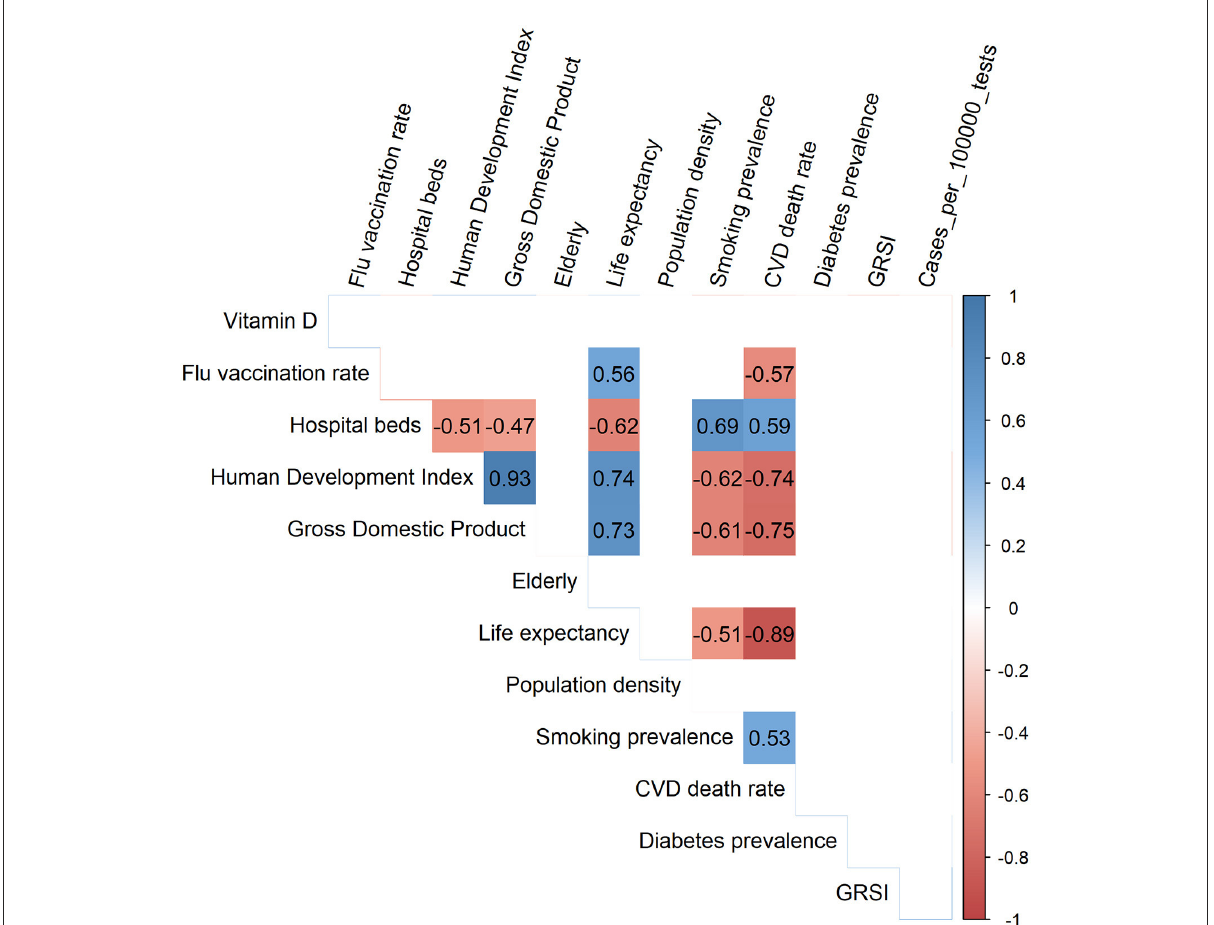
FIGURE2 Corrgram showing the Spearman correlation coefficients for all significant correlations among the 13 variables used for